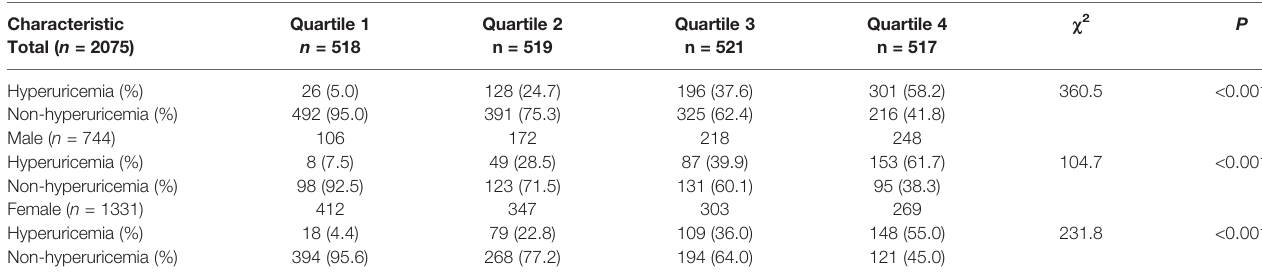
TABLE 3 | Prevalence of hyperuricemia by RBP4 quartile